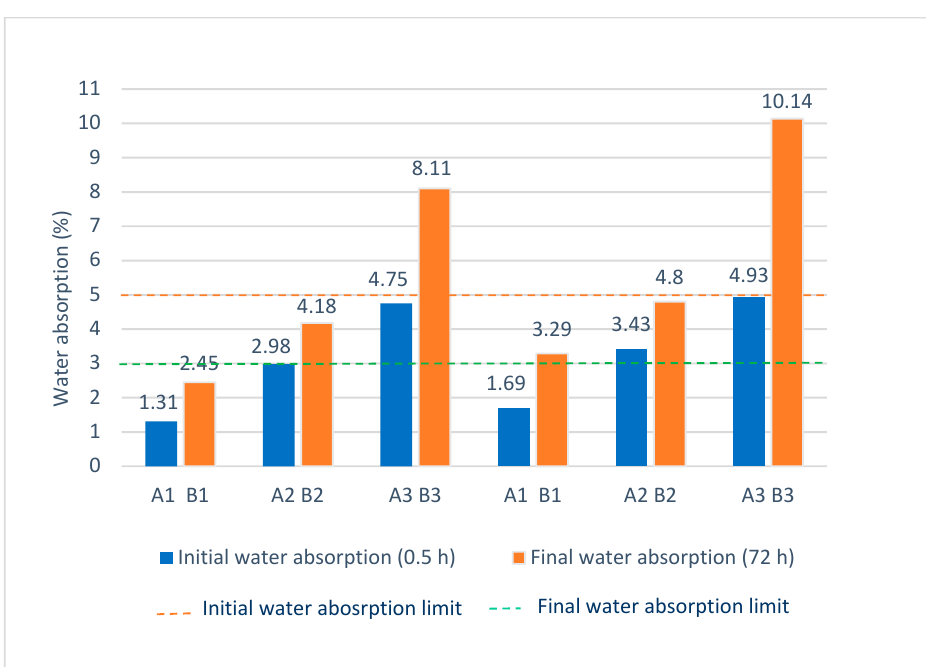
Figure 7. Comparison of initial and final water absorption for concrete mixes in series A and B.